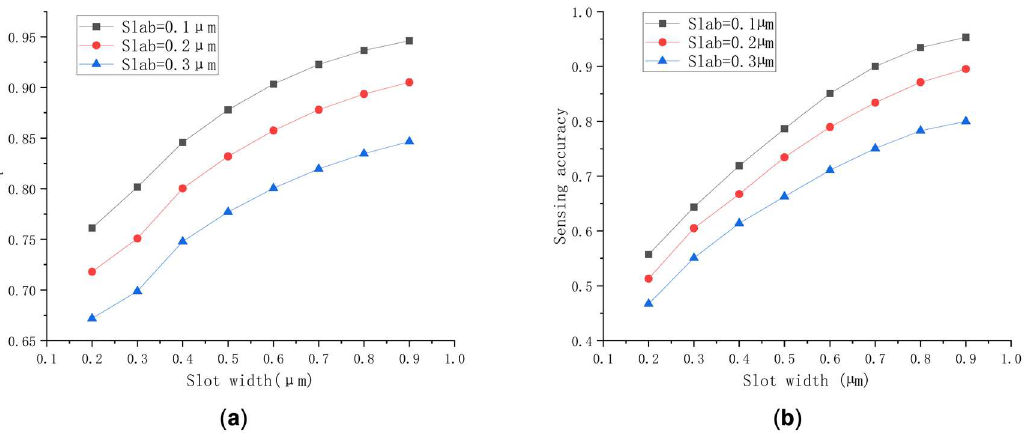
Figure 3. ( a ) Relationships between the value of η and the slot width with different slab sizes. ( b ) Relationships between 𝑆 (cid:3050) and slot width with different slab sizes .